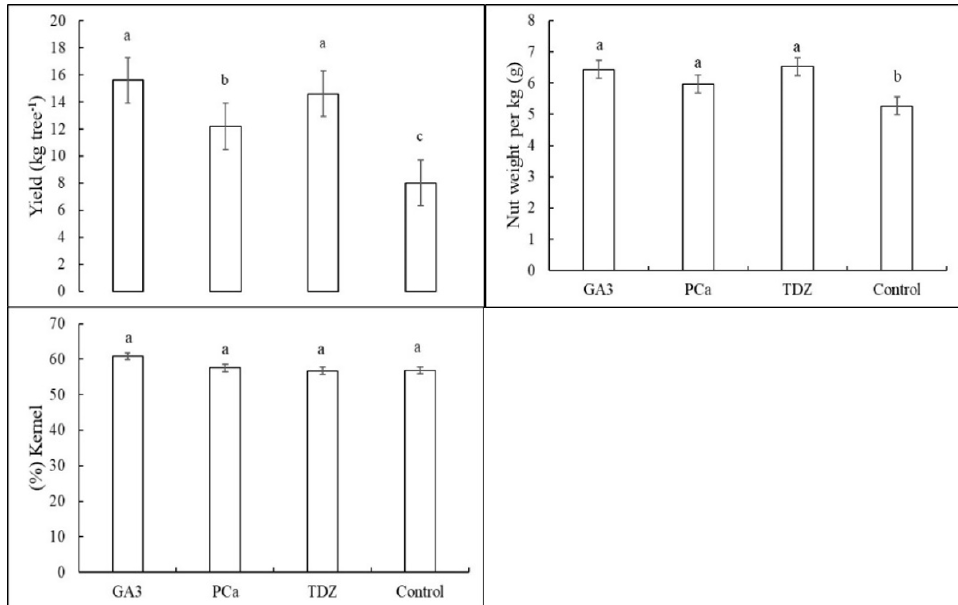
Figure 3. Yield, nut weight and kernel percentage in cv. Wichita pecan trees with the application of foliar treatments of growth regulators. The data are means of treatments in 2017 and 2018. GA 3: gibberellic acid (50 mg L − 1 ); PCa: prohexadione calcium (500 mg L − 1 ) and TDZ: thidiazuron (10 mg L − 1 ) and control. Bars with the same letter are not significantly different according to Tukey’s test ( p ≤ 0.05). Error bars represent standard deviations ( n = 5).